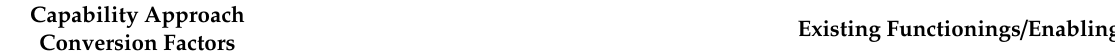
Table 1. Summary of applied enabling tools in the refurbishment process of